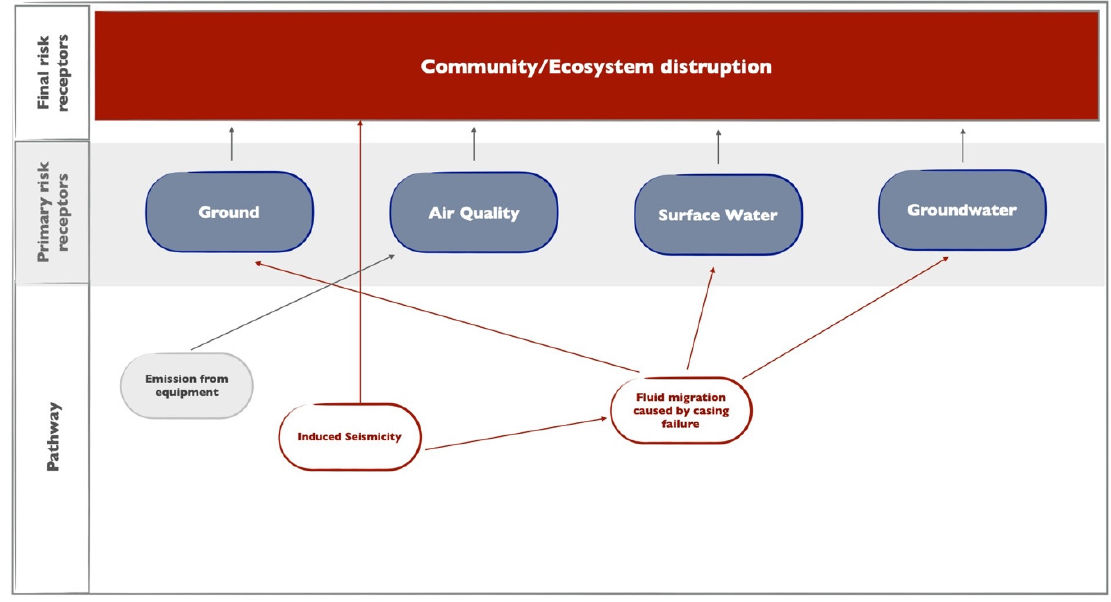
Figure 10. Risk pathways in Phase 3: Dismantle and end-of-life. Grey circles identify events related to ordinary routine operations, i.e., mostly of LCA analysis. Red circles identify events related to incidents and/or extreme events, i.e., those more closely related to MRA.